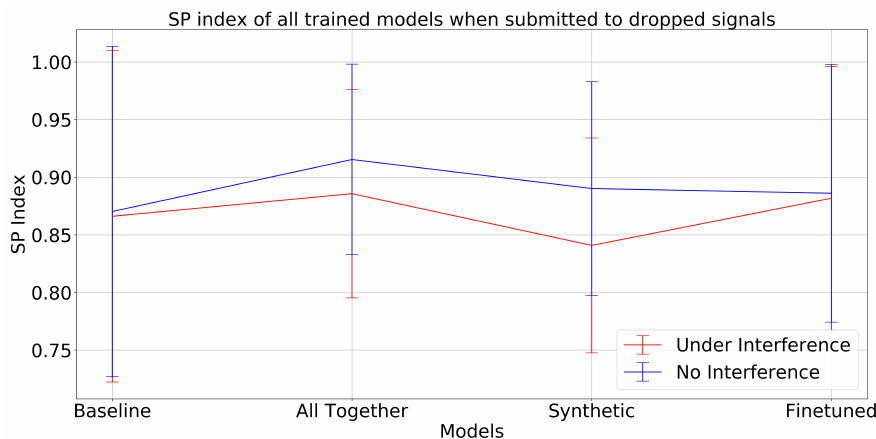
Figure 16. SP index computed for both nominal and dropping signal conditions. MaxPro design over LORO evaluation is considered and expert WGAN synthetic data production applies.